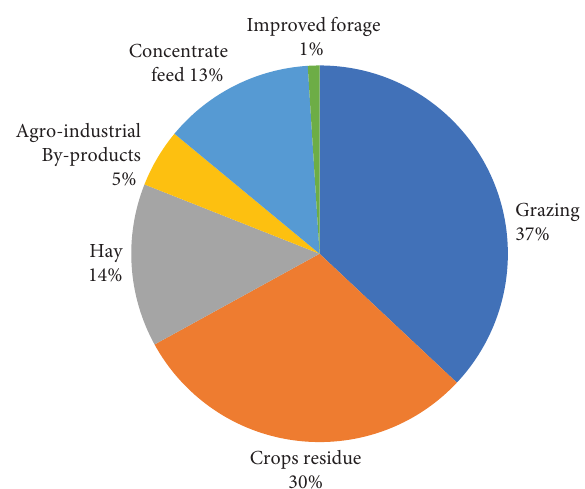
Figure 1: Te proportion of animal feed resources in Ethiopia